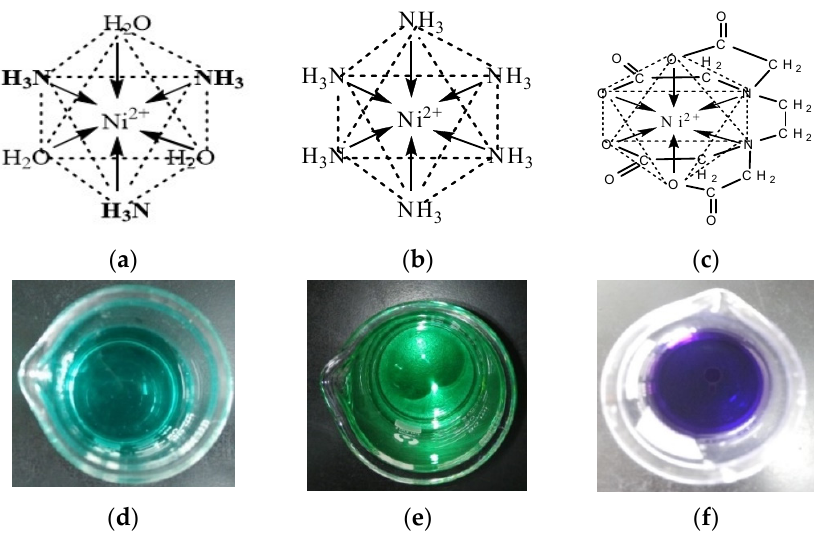
Figure. 3. The molecular structure of different electroactive ion species for Ni electrodeposition: ( a ) Ni(NH 3 ) 3 (H 2 O) 32+ , ( b ) Ni(NH 3 ) 62+ , and ( c ) Ni chelate. The photographs of 0.2 M NiCl 2 , 2 M NH 4 Cl, and 1 M NaCl solutions with different pH values of 3 ( d ) and 7.7 ( e ), and with 0.1 M EDTA ( f ).